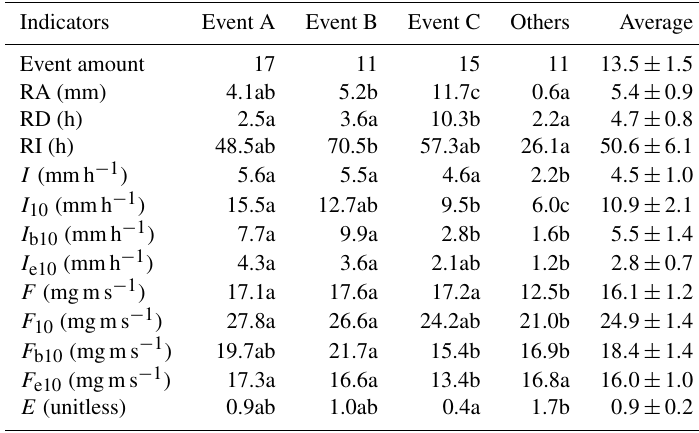
Table 2. Rainfall characteristics during events with different intensity peak amounts.